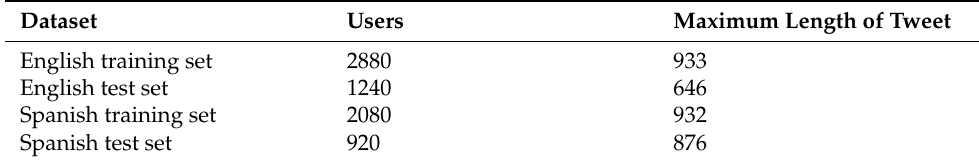
Figure 4. Account description. Table 1. Data description.